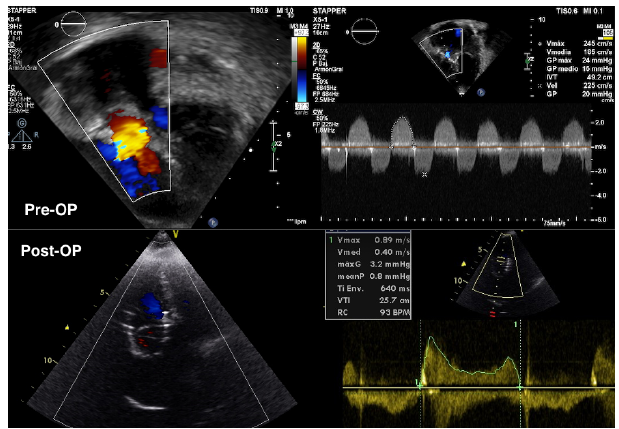
Fig. 1 - Pre-OP: tricuspid valve gradient before implantation. Post- OP: tricuspid valve gradient 1 year after surgery.